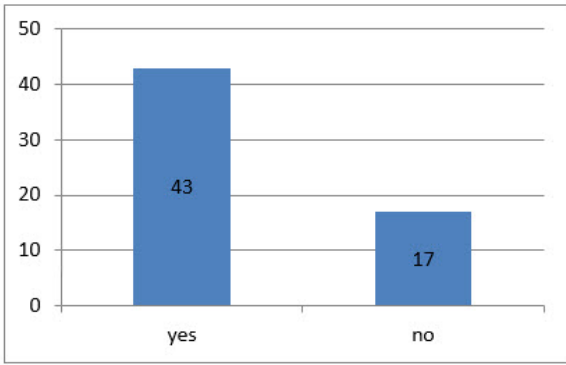
Figure 3. Number of the respondents who consider real time comment writing